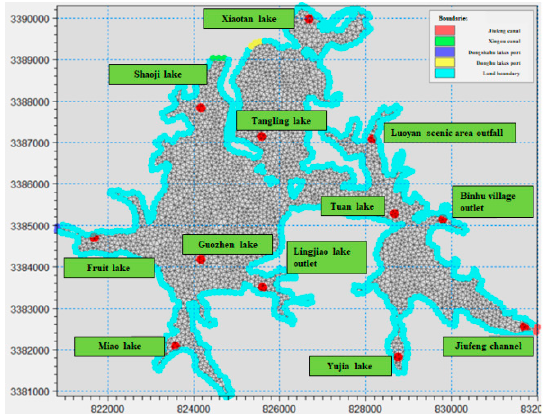
Figure 12. Supplementary results of pollution sources.